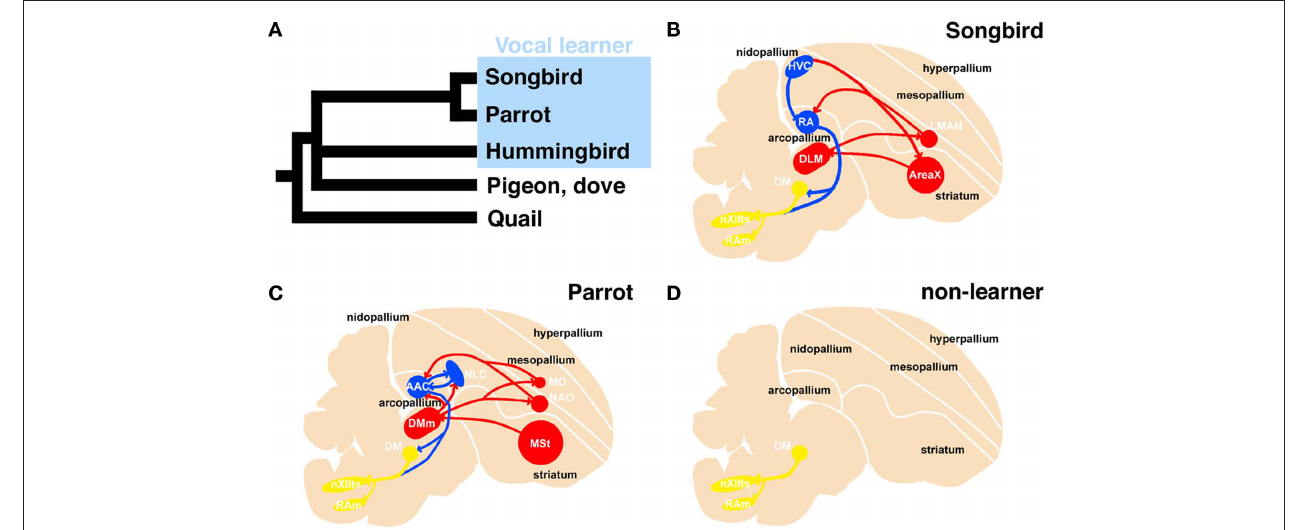
AAC-DMm-NAO-AAC anterior pathway (C) . In contrast, such neural circuits for vocal learning are not found in the quail brain (D) . A similar neural circuit is found in the brainstems of these species to produce learned or innate vocalization. The red and blue lines indicate anterior and posterior pathways for vocal learning, respectively. The yellow line indicates the general vocalization pathway seen in the brainstem of avian species. AAC: central nucleus of the anterior arcopallium, DLM, dorsal lateral nucleus of the thalamus; DM, dorsal medial nucleus of the midbrain; DMm, magnocellular nucleus of the dorsal thalamus; LMAN, lateral magnocellular nucleus of the anterior nidopallium; NAO, oval nucleus of the anterior nidopallium; NLC, central nucleus of the lateral nidopallium; RA, robust nucleus of the arcopallium; nXIIts, tracheosyringeal